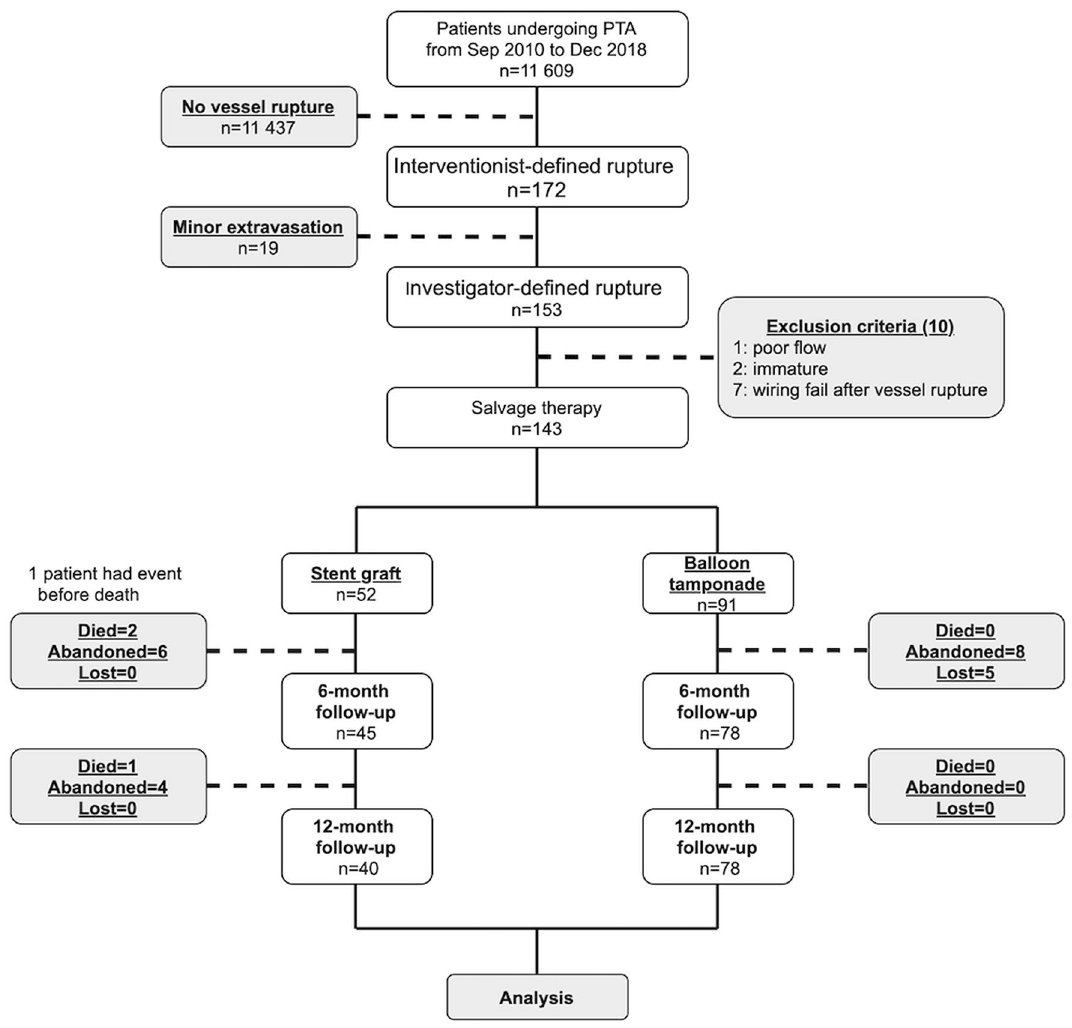
Figure 1. Flow diagram of the study subjects. PTA percutaneous transluminal